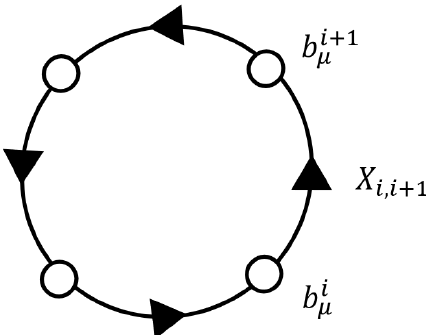
Figure 2: Quiver diagram for the 2 + 1 dimensional deconstruction of maximally supersymmet- ric electromagnetism. Nodes (white circles) correspond to U ( 1 ) gauge groups, links (black arrows) to bifundamental